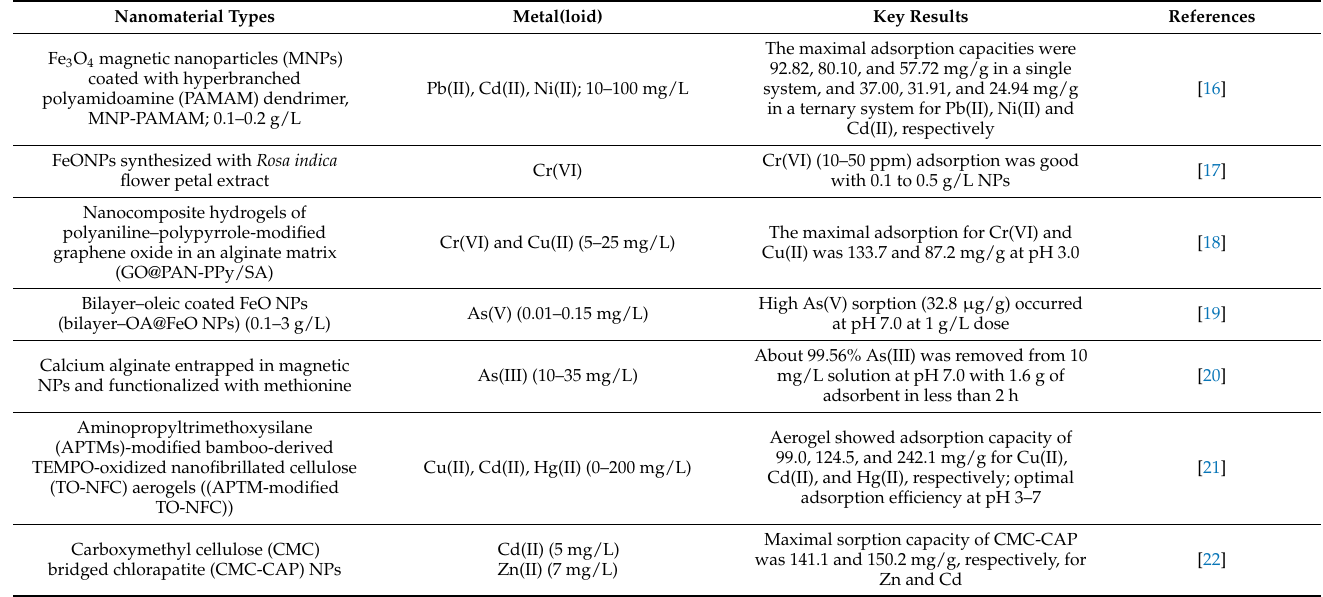
Table 1. Applications of nanomaterials in metal(loid) remediation from the environment.